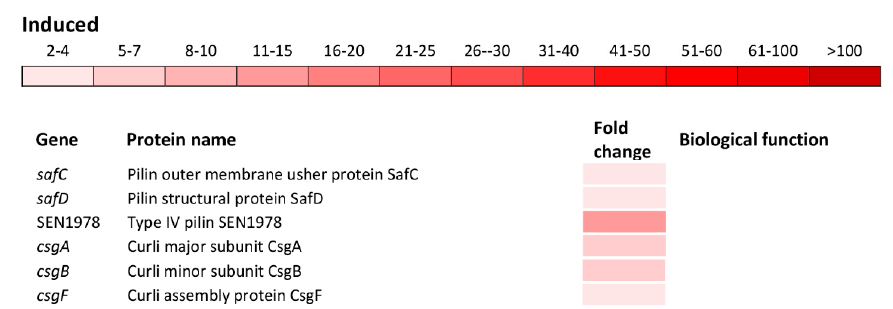
Figure 5. Differential expression of genes involved in pathogenesis and cell adhesion. The mean fold-increase in each gene expression after exposure to 3 mM of H 2 O 2 compared with controls is indicated by the color scale bar.